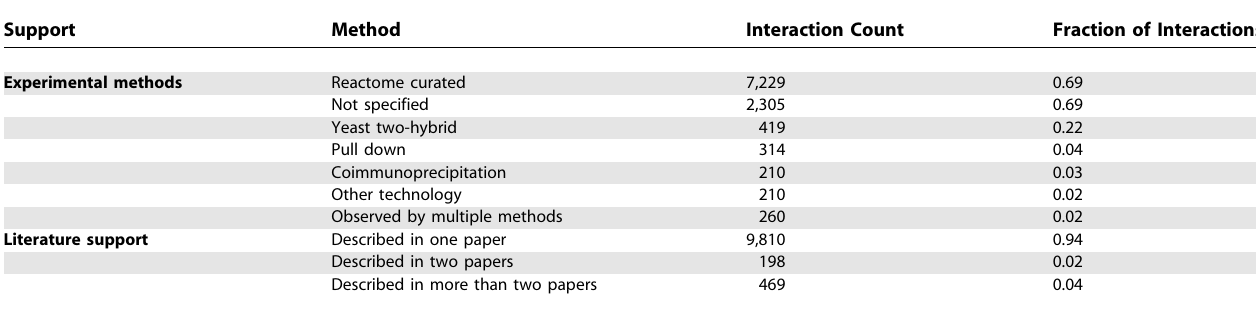
Table 2. Interaction Method and Support Summary